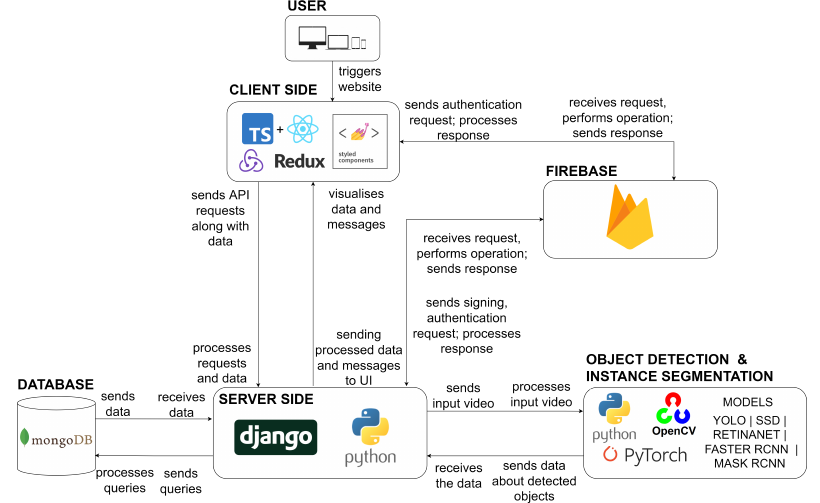
Figure 8. Architecture